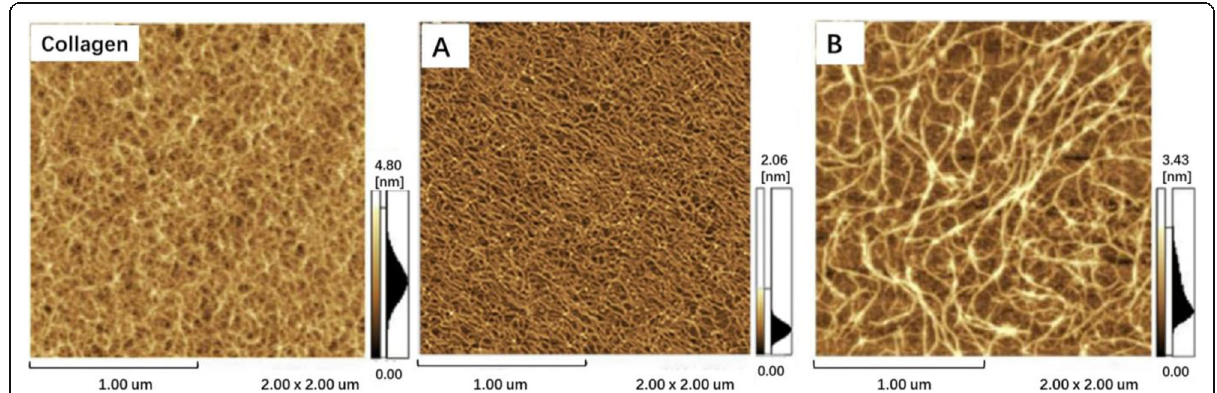
Fig. 5 AFM images of the native collagen and the insoluble collagen fibers derived from 70% [EMIM][BF 4 ] ( a ) & [EMIM][Ac] ( b ) respectively. Adapted with permission from [150]. Copyright © 2019, Springer